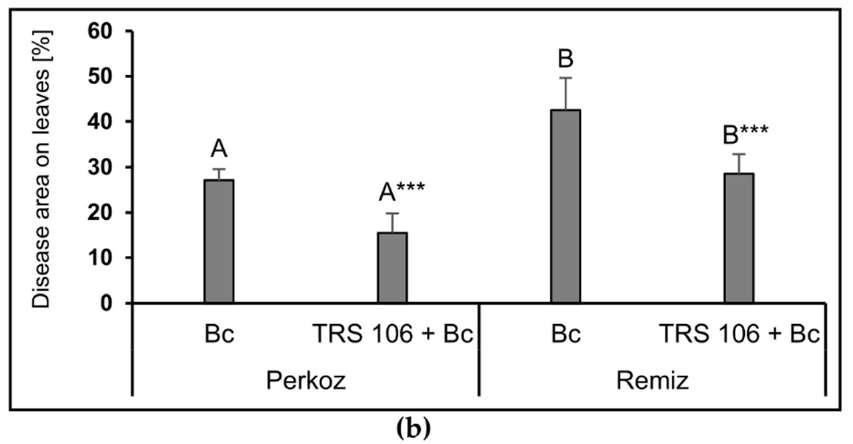
Figure 2. ( a ) Effect of TRS 106 on the tomato plants protection against B. cinerea . Evaluation of the disease symptoms, i.e., irregular brown lesions, dark brown blight blotches, and rot symptoms on leaves; ( b ) disease area on leaves, occurring on 5-week-old tomato plants caused by B. cinerea , 72 h after inoculation. Values represent the means + SE from four independent experiments with three replicates each (n = 12). Differences between cultivars within a given variant were analyzed with Student’s t -test and marked using letters A and B. Separately for each cultivation, differences between Bc and TRS 106 plants were analyzed with Student’s t -test and marked using asterisk symbol (*** p < 0.001). Data points followed by a different letter are significantly different at p ≤ 0.05. Abbreviations are as in Figure 1.